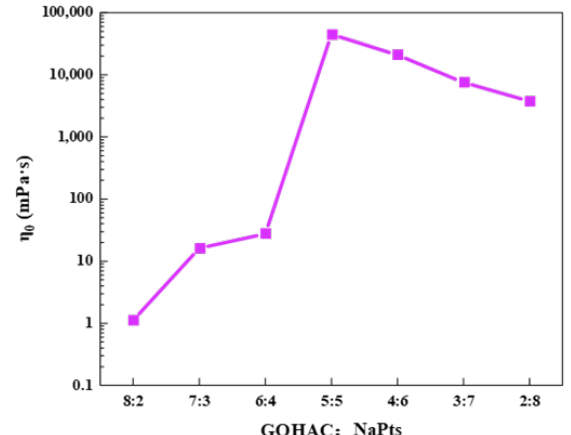
Figure 6. Steady shear viscosity of GOHAC/NaPts gel solution at different radios (the total concen- tration of GOHAC and NaPts is 40 mmol/L).